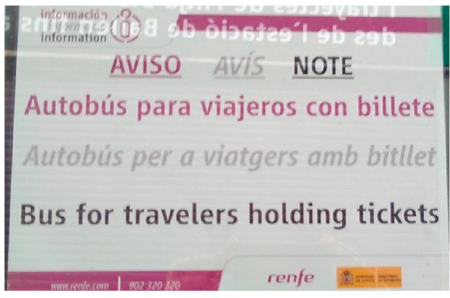
Figure 22. Valencia: Trilingual sign on a bus station.